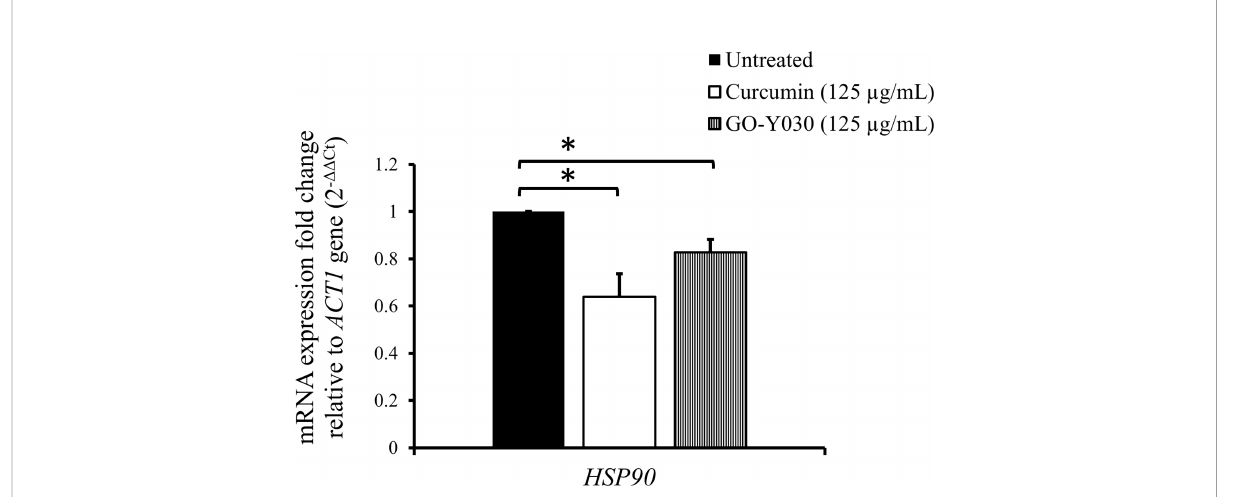
FIGURE 2 Effect of curcumin compounds on HSP90 gene expression in C. albicans SC5314. Error bars represent standard deviation from the mean of duplicate measurements. * indicates a statistically signi fi cant difference (p<0.05) compared to the respective control group.